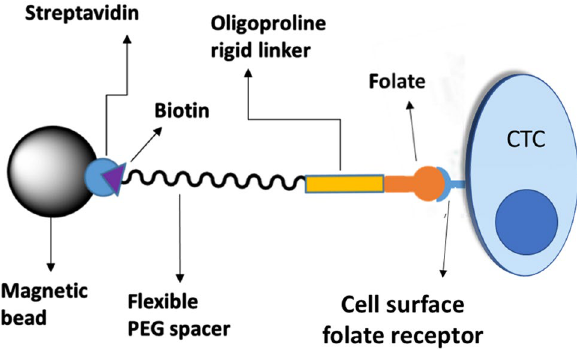
Figure 1. Design of an optimal circulating tumor cell (CTC) capture